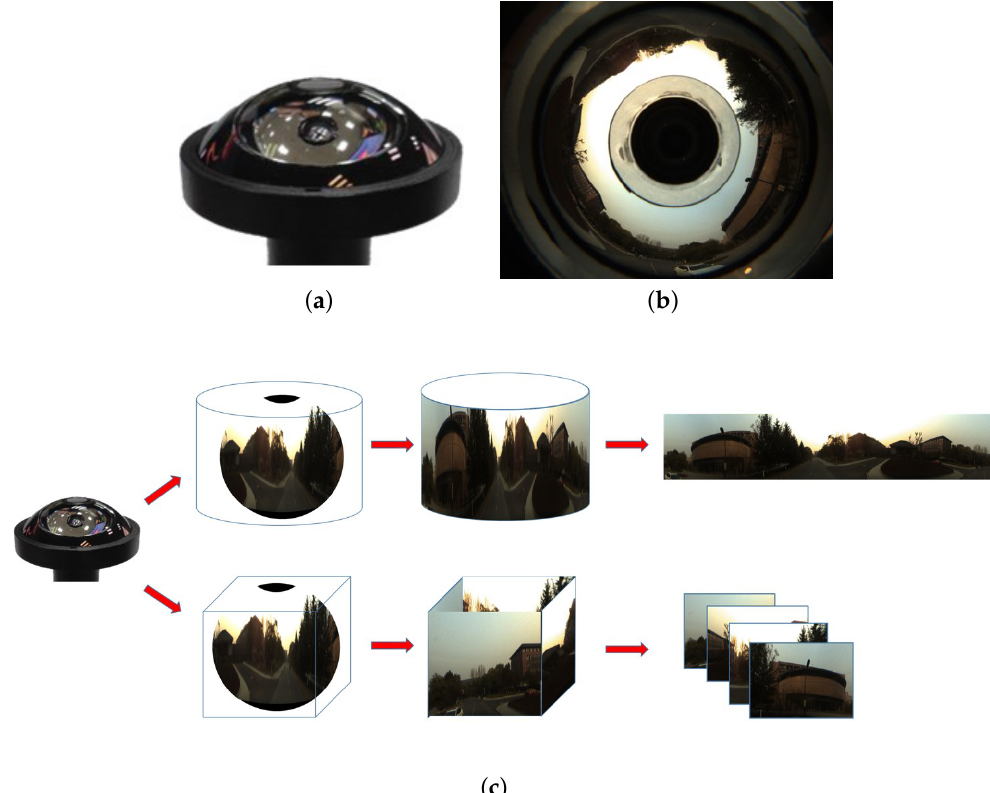
Figure 4. ( a ) PAL; ( b ) a panoramic annular image imaged by PAL; ( c ) two panoramic annular image processing forms. The upper method projects the unit spherical surface onto a cylinder, while the bottom method projects the unit spherical surface onto a